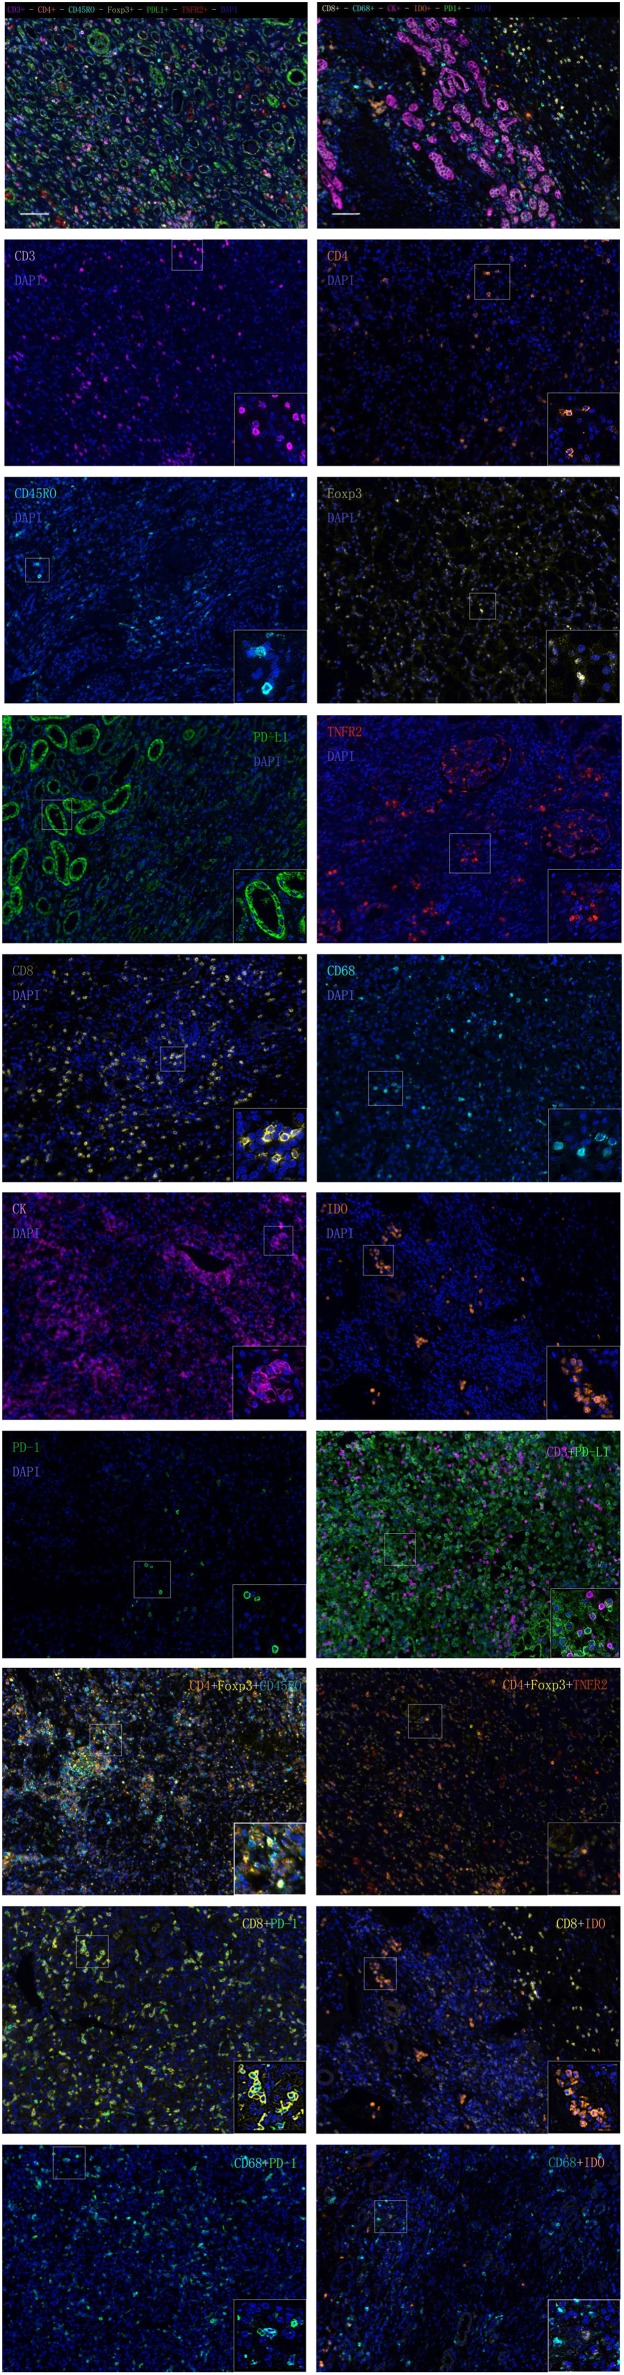
Multiplex fluorescent immunohistochemistry staining.